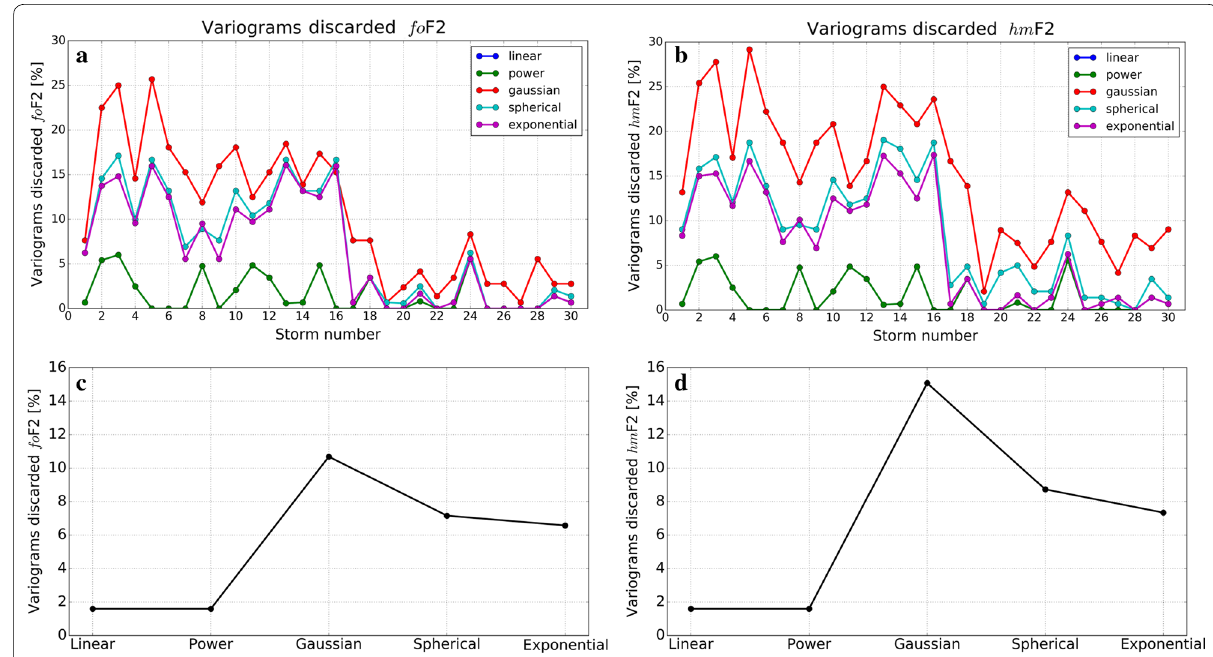
Fig. 12 Percentage of variogram models discarded by the NQCR procedure. Percentage of discarded variogram models for (top) each storm listed in Table 3 and (bottom) all storms as a whole, for (left) fo F2 and (right) hm F2. On the top panels the percentage of the linear model is not visible because hidden by the power model